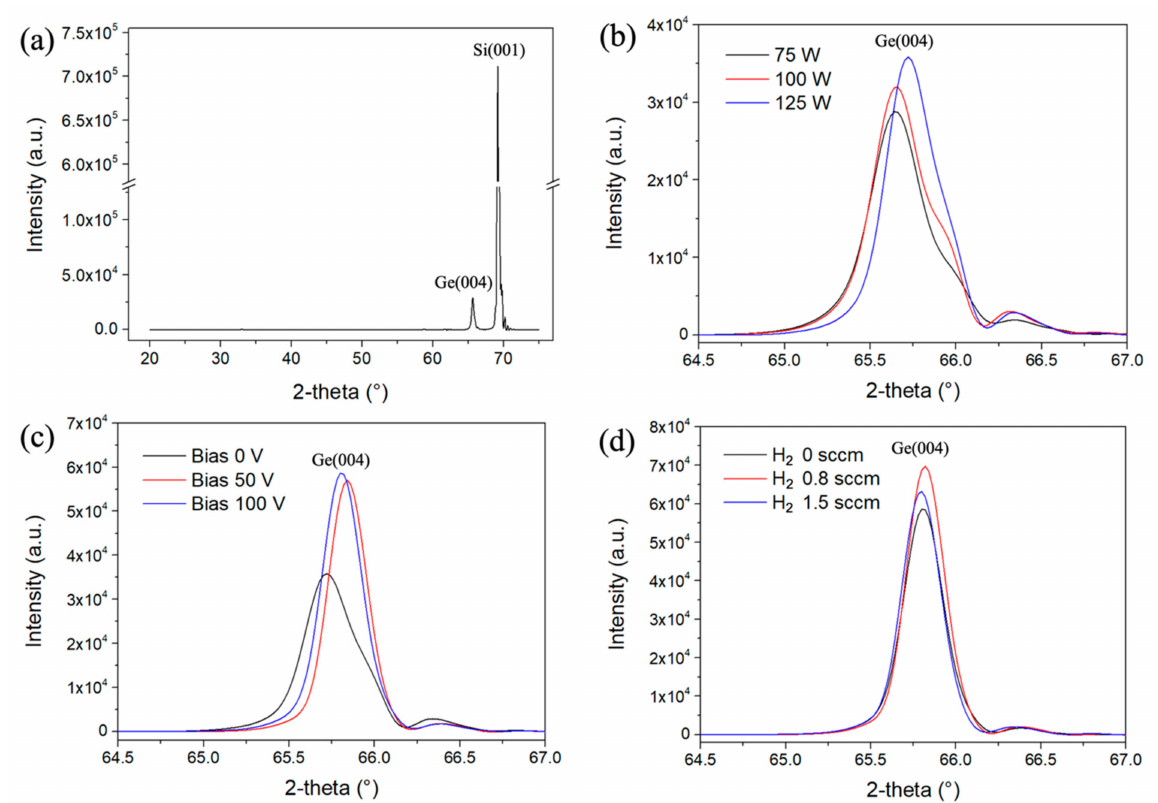
Figure 2. XRD two-theta mode measurement of RF sputtered Ge thin films on Si substrates with ( a ) wide 20 ◦ –80 ◦ scan range; ( b ) varying sputtering power (75, 100 and 125 W); ( c ) varying substrate bias voltage (0, 50 and 100 V); and ( d ) varying hydrogen flow (0, 0.8 and 1.5